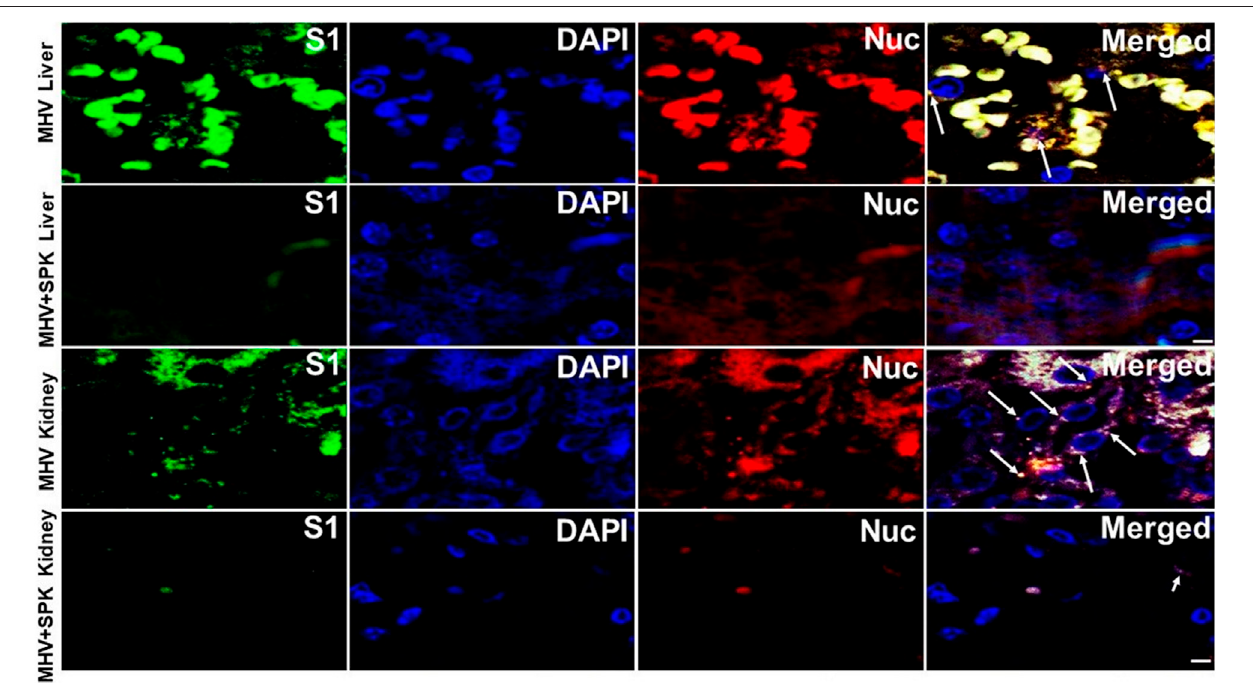
FIGURE 10 | The presence of MHV-1 virus with and without SPK treatment in liver and kidney. The long arrows indicate the presence of viral particles (S1 and Nucleocapsid) inthelivers andkidneysofMHV-1 infected mice.The short arrows inthekidney indicate thereduced levelofviral particles intheSPK treatedgroup, while viral particles are absent in the liver post-SPK treatment. n = 4. Scale bar = 30 μ